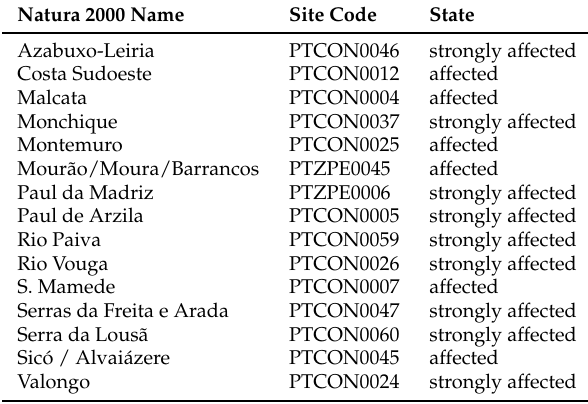
Figure 7. Map of the evaluation area. The determined mean probability of a pixel being covered with Eucalyptus is shown for the study area in the range from 0 (black) to 1 (white) for the year 2018. The Natura 2000 areas that were studied are highlighted with red outlines. The landmass is visualized as a gray background. Table 3. Summary of the affected Natura 2000 sites that are in large parts covered with Eucalyptus . Strongly affected sites were found to have populations of Eucalyptus outside of regular plantations. See Table A4 for sites that have been found to be not affected or only